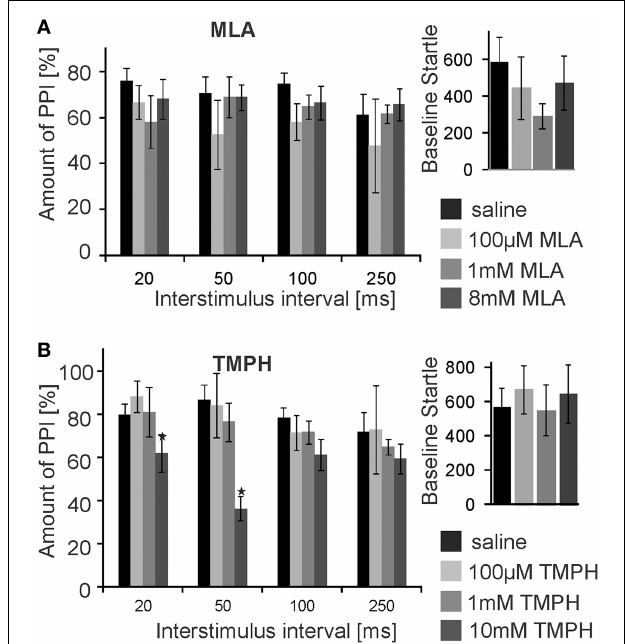
FIGURE 3 | PnC microinfusion of TMPH, but not of MLA, into the PnC disrupts PPI. (A) Intracranial microinfusions of the α 7 preferring nicotinic antagonist MLA into the PnC in doses as indicated does not significantly affect PPI at any ISI. Local MLA infusion has also no significant effect on the baseline startle amplitude ( n = 6 rats). (B) Intracranial microinfusions of TMPH significantly disrupted PPI at the highest dose tested. The effect was restricted to short ISIs of 20 and 50ms. TMPH did not affect the baseline startle ( n = 10